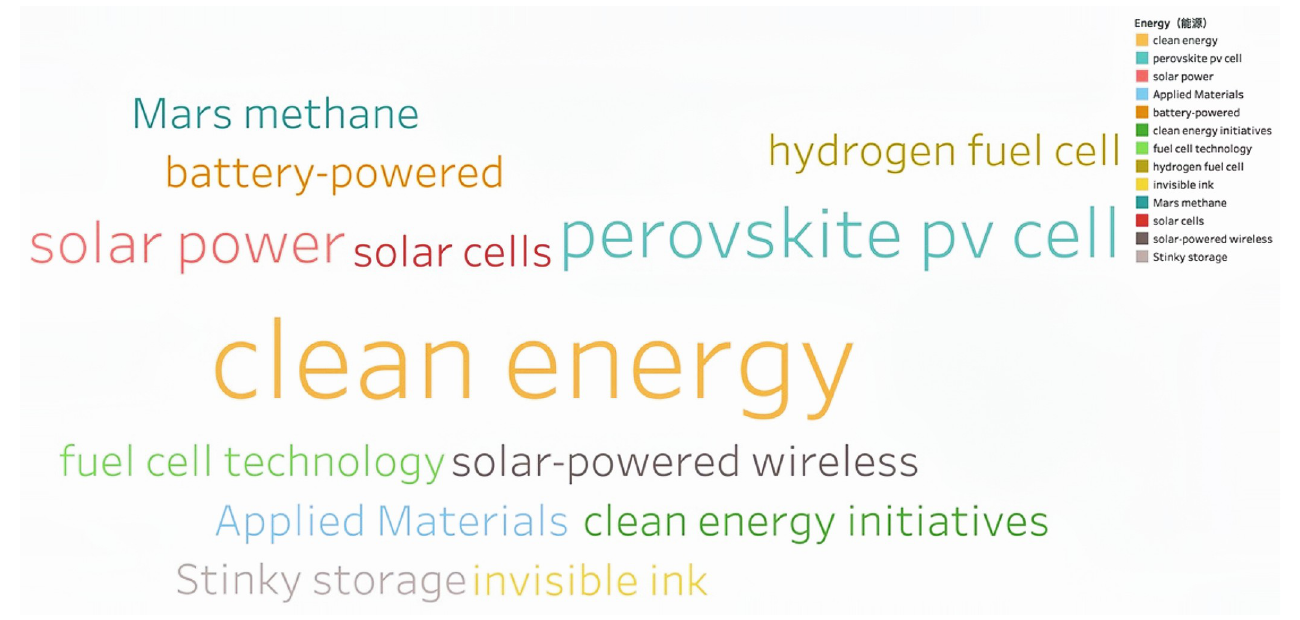
Fig 5. Word cloud diagram of Energy field.